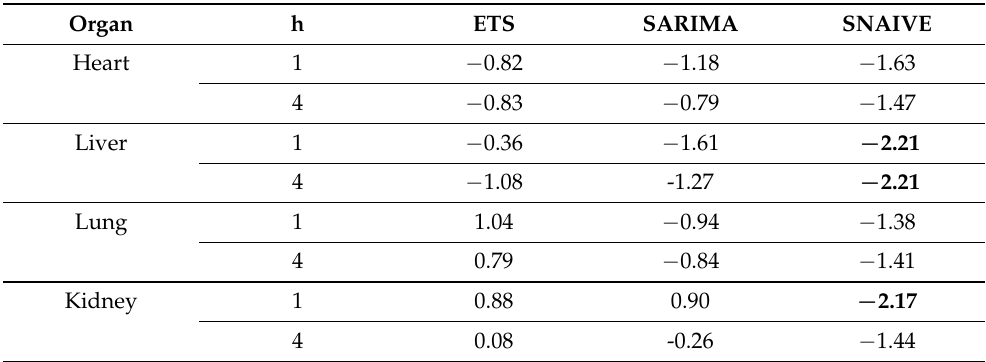
Table 4. Results of the modified Diebold–Mariano test comparing ITSA to ETS, SARIMA without intervention, and SNAIVE by organ